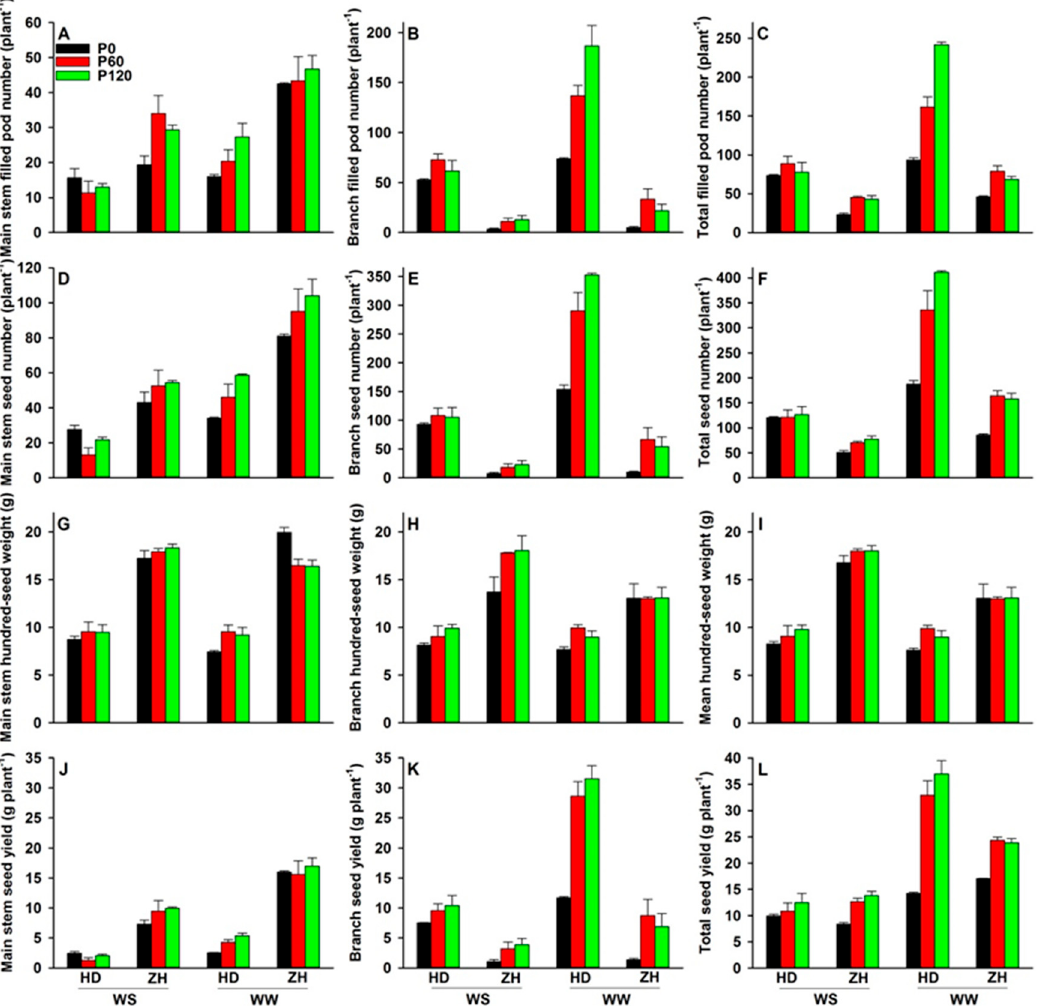
Figure 5. Filled pod number per plant, seed number per plant, hundred-seed weight and seed yield per plant at maturity on the main stem ( A , D , G , J ), branches ( B , E , H , K ) and both the main stem and branches ( C , F ,I, L ) of soybean genotypes Huangsedadou (HD) and Zhonghuang 30 (ZH) with three levels of applied P (0 (P0), 60 (P60) and 120 (P120) mg P kg –1 dry soil) and two water treatments (well-watered (WW) and cyclic water stress (WS)). Values are means + one standard error of the mean ( n = 3).